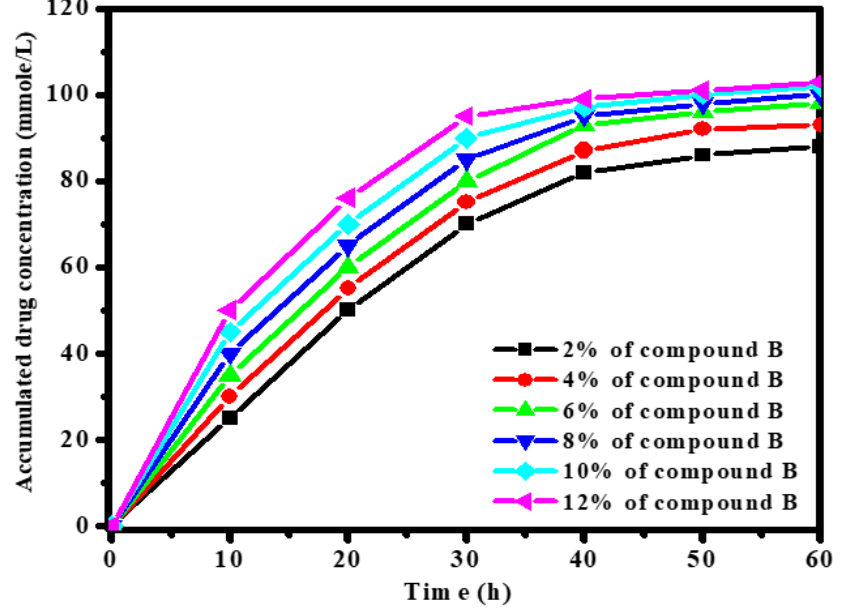
Figure 5. Effect of 3β -Acetoxy- 5α -cholestano- 2′ -methyl-2-oxazoline (B) concentration [2,4,6,8,10,12] % on release rate.